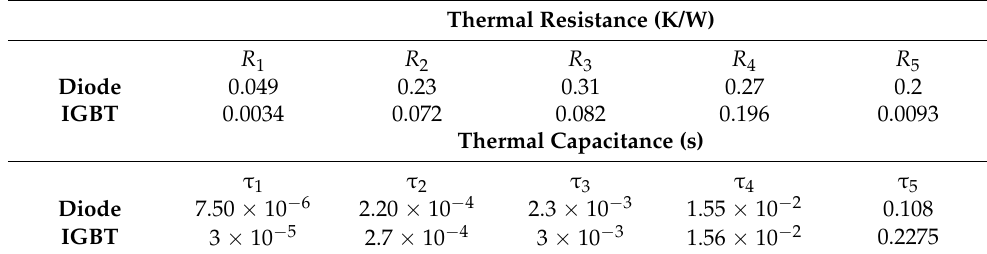
Table 5. Heat sink thermal parameters. Heat sink part number